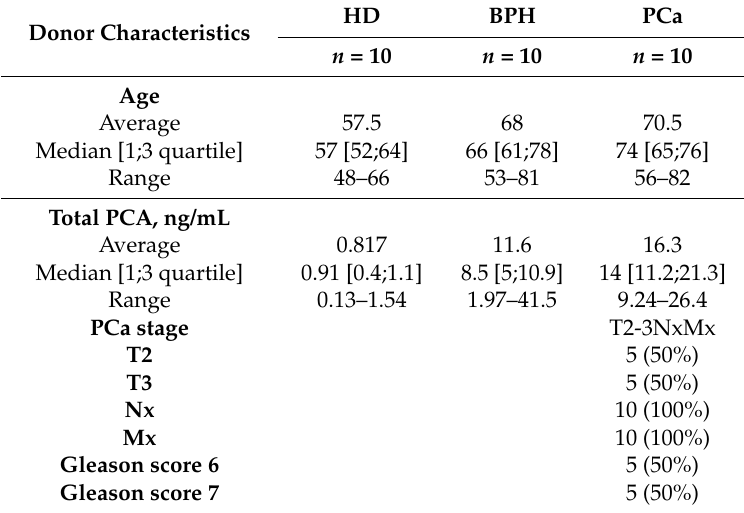
Table 6. Clinicopathological and demographic characteristics of healthy donors and patients with BPH and cancer. Donor